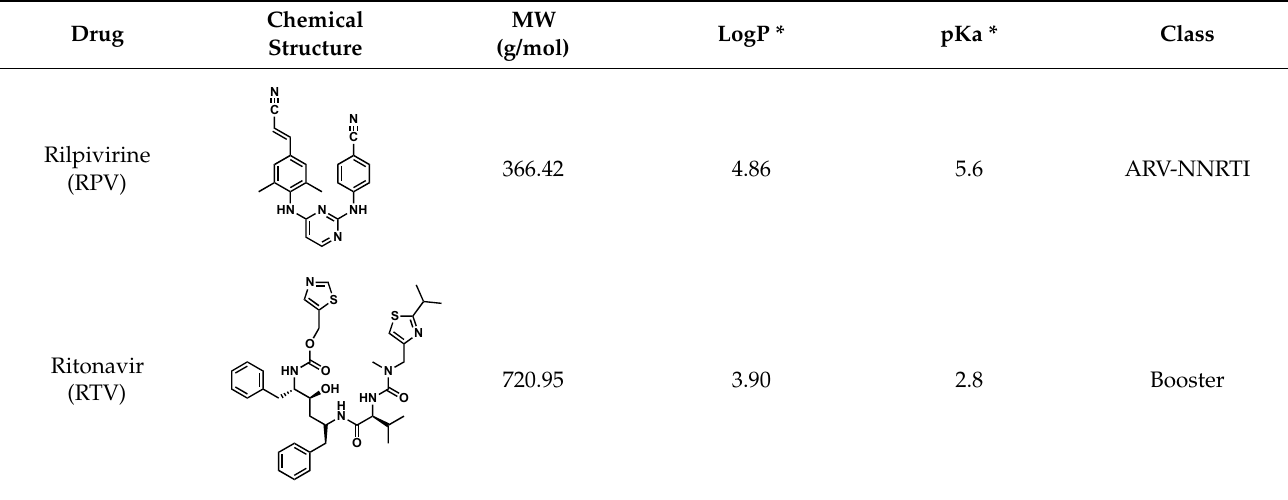
Table 1. Physicochemical properties of drugs tested in ISFIs.